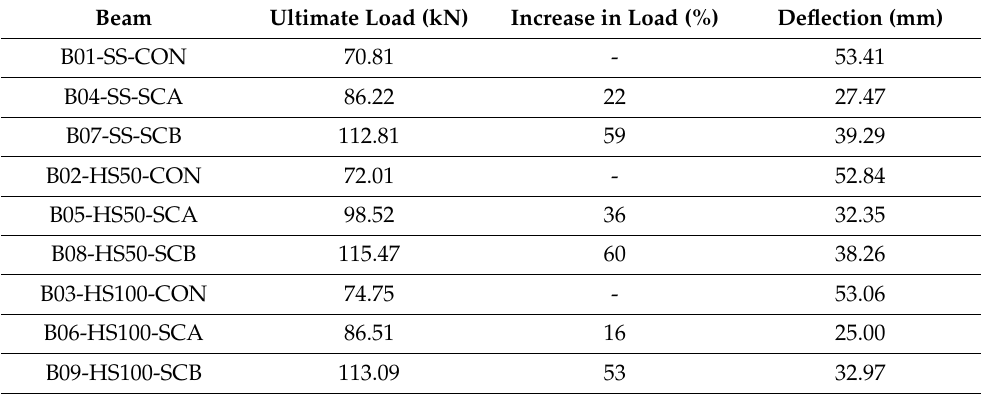
Table 3. Key parameters obtained from load-deflection